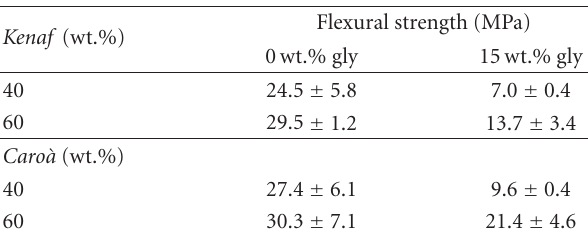
Table 2: Flexural ultimate strength of soy composites.